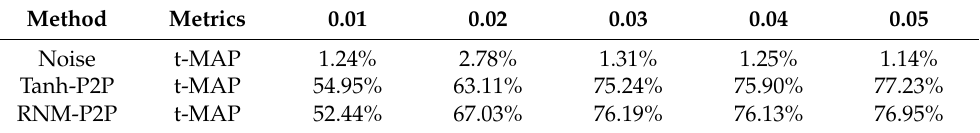
Table 2. The t-MAP (%) of targeted attack with variable parameter τ on NUS-WIDE dataset with 24-bit hash